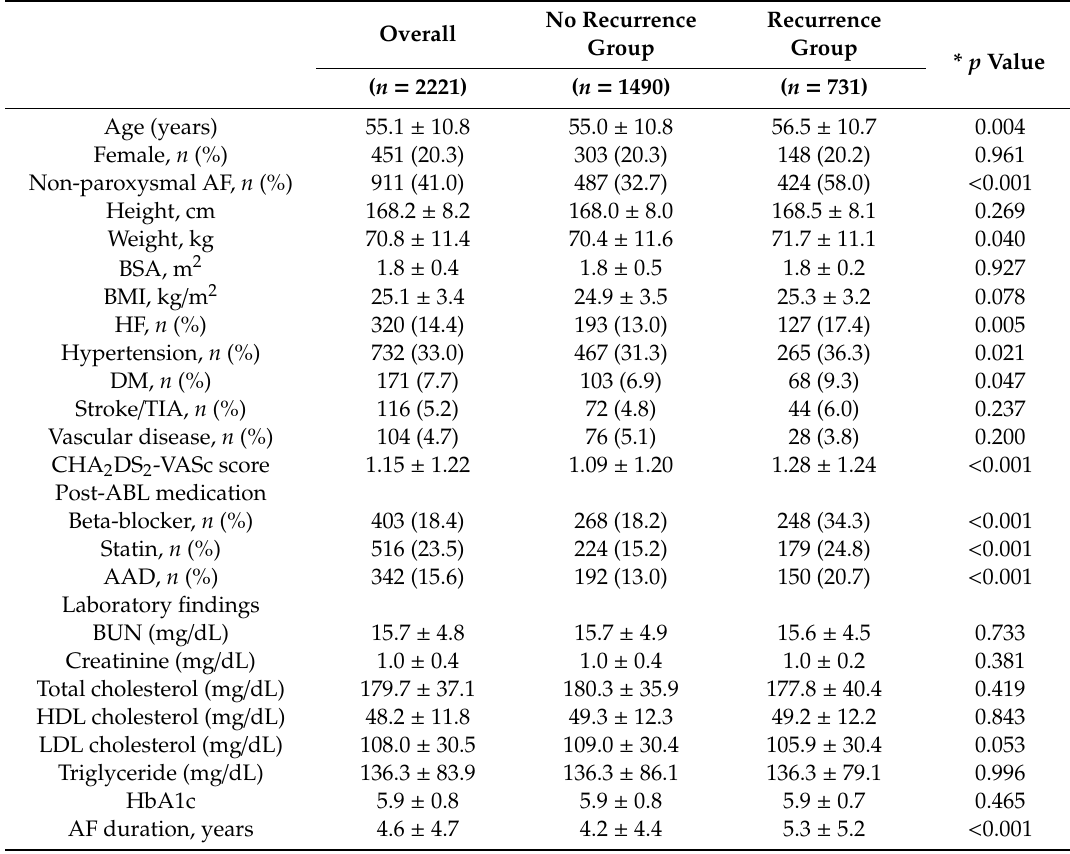
Table 1. Baseline clinical characteristics of study patients according to clinical recurrence after catheter ablation. No Overall